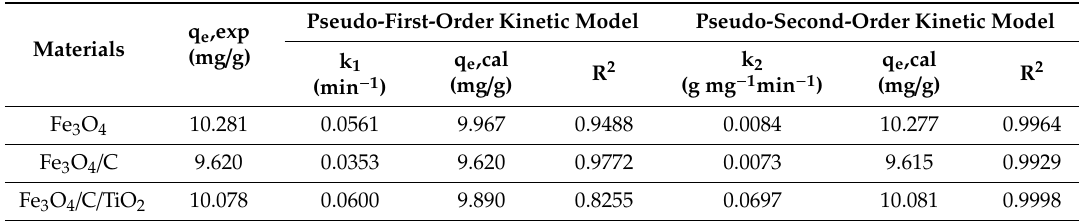
Table 2. Parameters of the pseudo-first-order (PFO) and pseudo-second-order (PSO) models. Pseudo-First-Order Kinetic q e ,exp Materials Materials q e ,exp (mg/g) (mg / g)